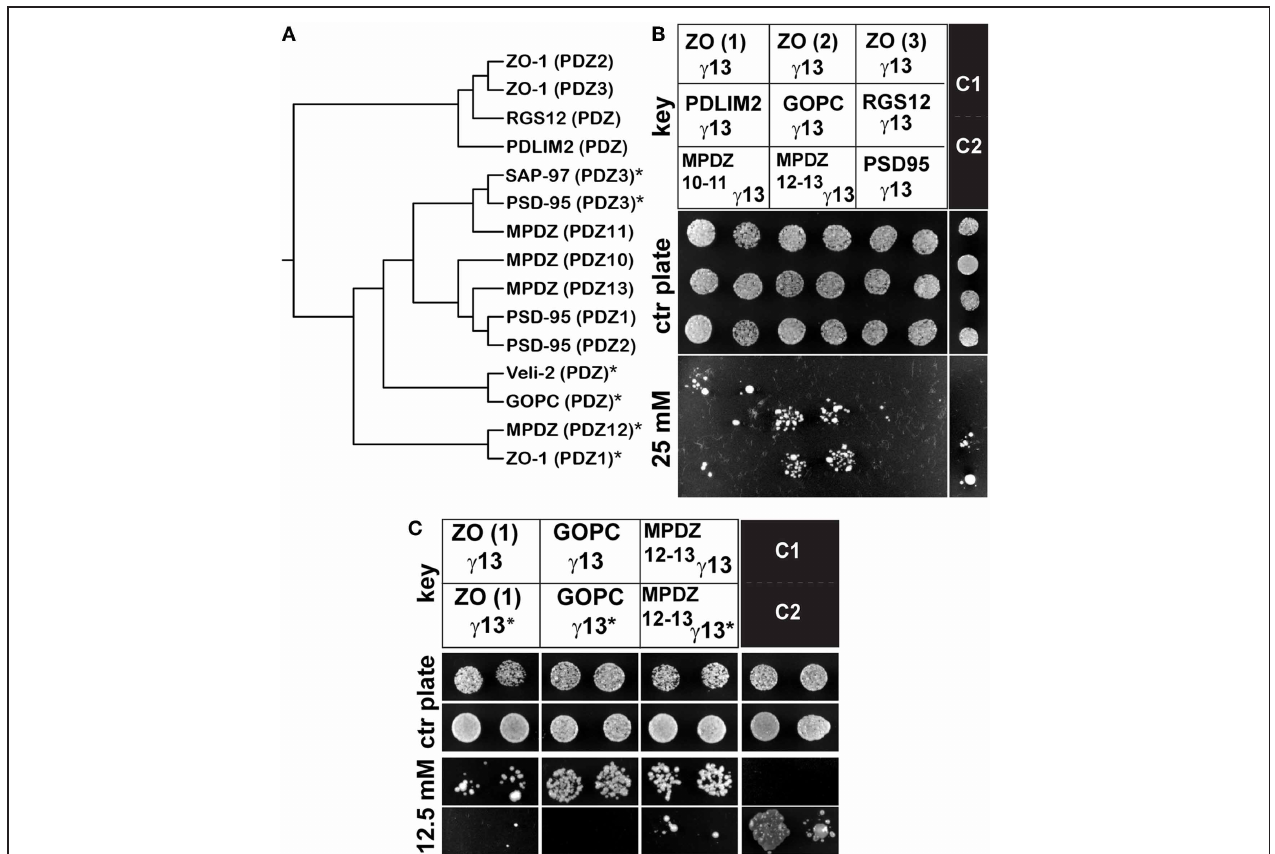
FIGURE 1 | G γ 13 interacts with the PDZ domains of GOPC, MPDZ and ZO-1. (A) Phylogenetic tree of a selection of PDZ domains. Sequences encompassing the PDZ domain region of several proteins were analyzed with clustalW 2.1. using the PAM weight matrix. The PDZ domains presenting the highest homology are closer together on the tree. ( ∗ ) PDZ domains interacting with G γ 13. (B) Individual constructs encompassing each of the ZO-1 PDZ domains (PDZ1, PDZ2, PDZ3), PDZ10-11, and 12–13 of MPDZ, PDZ3 of PSD95 or the unique PDZ domains of PDLIM2, GOPC, and RGS12 (see key) were co-transformed together with G γ 13 into MaV203 competent yeast cells and assayed for growth on medium lacking His, Leu, and Trp supplemented with 0 (control plate) or 25mM 3-AT. ZO-1 (PDZ1), GOPC, and MPDZ (PDZ12-13) are clearly interacting with G γ 13. C1 and C2 are